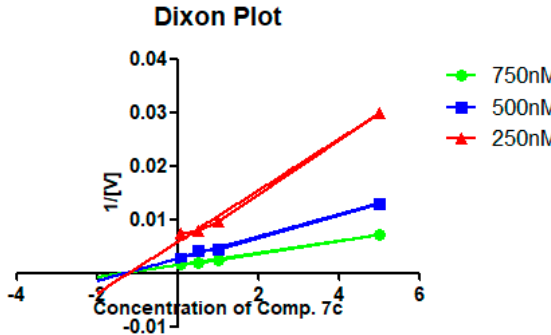
Figure 7. Kinetic analysis of 7c . The inhibitor was tested in the presence of different concentrations of substrate: 250 nM ( ▲ ), 500 nM ( ■ ), and 750 nM ( ● ). BACE1 ( β -site amyloid precursor protein cleaving enzyme 1) inhibition was analyzed in the presence of different concentrations of sample as follows: 0.1 μ M, 0.5 μ M, 1.0 μ M, 5.0 μ M.